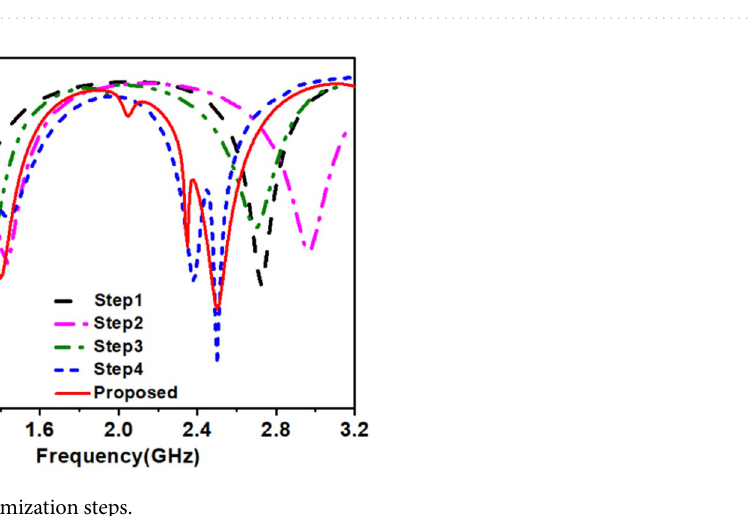
Figure 4. Antenna’s design evolution ( a ) step-I ( b ) step-II ( c ) step-III ( d ) step-IV ( e ) proposed antenna (step-V).